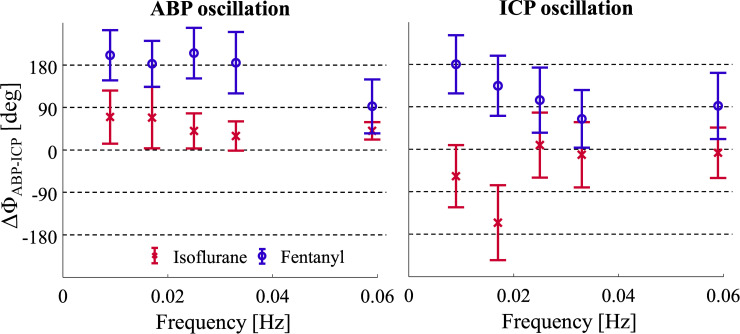
The phase lag between ABP and ICP during oscillations in ABP (left) and ICP (right). Red markers show isoflurane anesthesia group averages with error bars spanning the standard deviation. Blue markers show the fentanyl group.